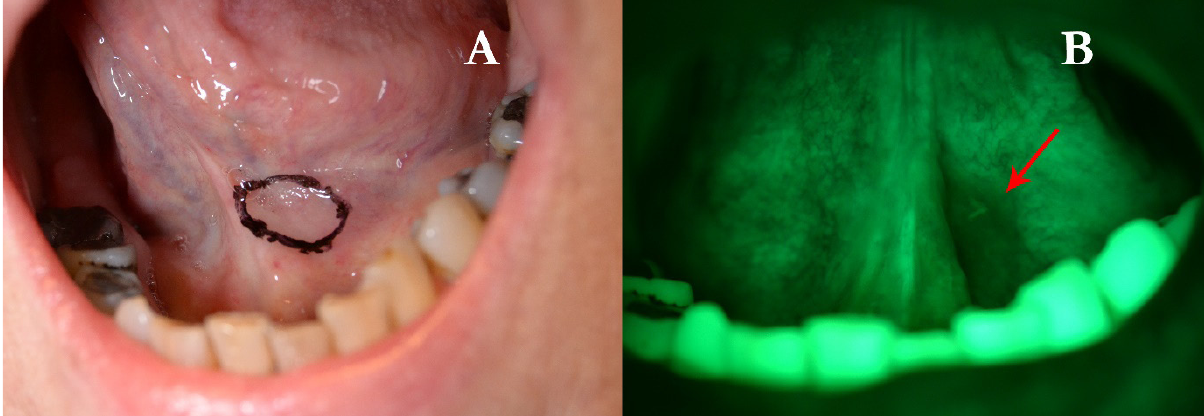
Fig. 1. The appearance of the lesion under normal light (A) and VELscope®